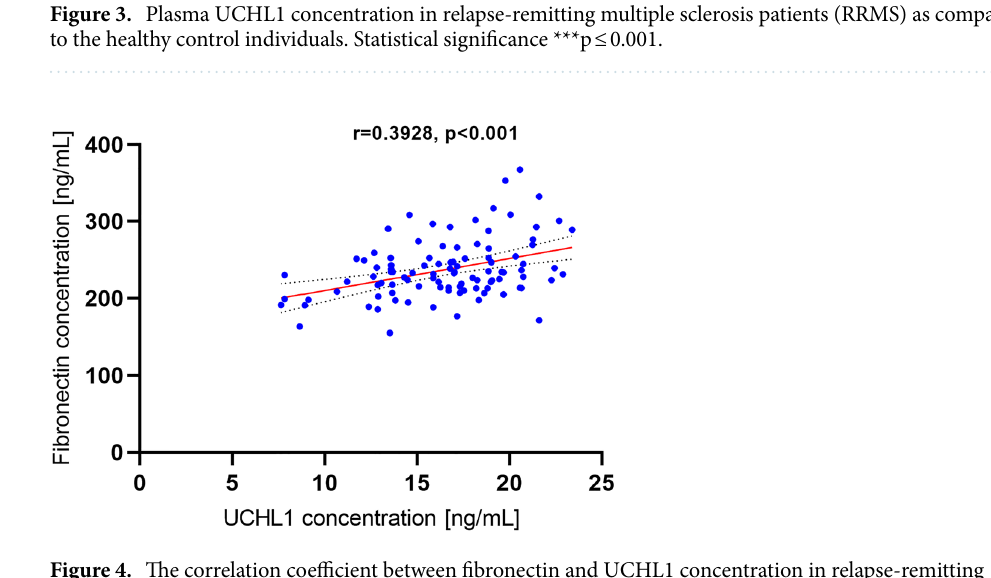
Figure 4. The correlation coefficient between fibronectin and UCHL1 concentration in relapse-remitting multiple sclerosis patients.